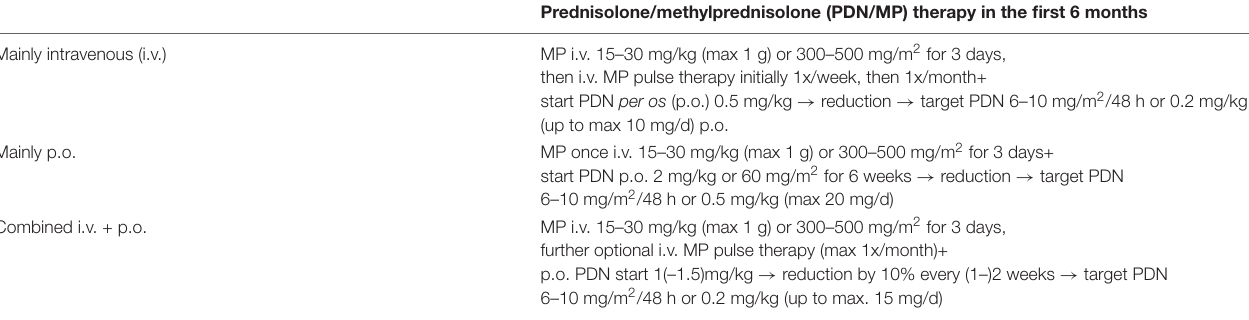
TABLE 4 | Suggested corticosteroid induction therapies for proliferative lupus nephritis class III or IV (adapted from Refs. 17, 63). Prednisolone/methylprednisolone (PDN/MP) therapy in the first 6 months Mainly intravenous (i.v.)